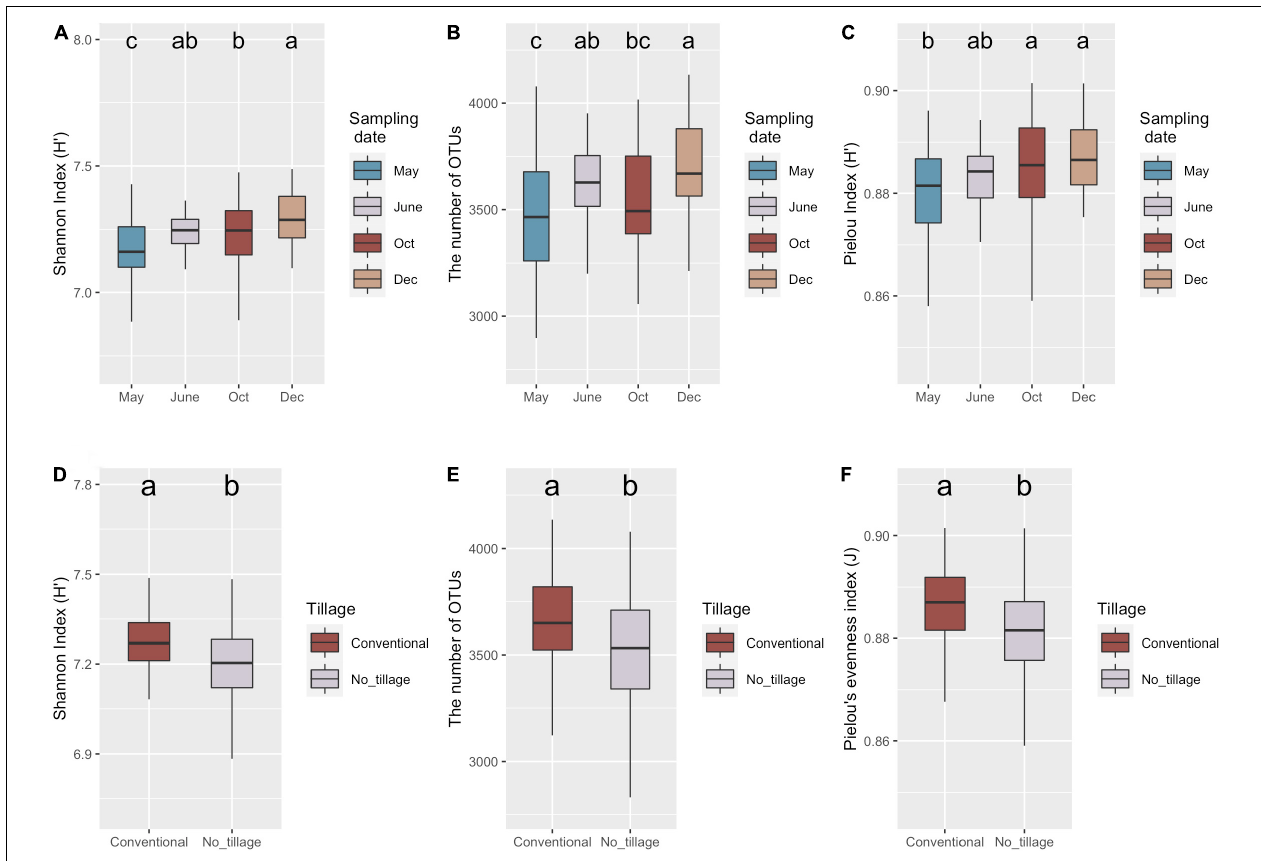
FIGURE 2 | Variations of soil bacteria diversity under long-term management practices during the cotton production cycle. Boxplot of bacterial richness and evenness across four sampling dates (A–C) and tillage management. Shannon (A,D) , the number of OTUs (B,E) , and Pielou’s evenness (C,F) indices represented bacteria alpha-diversity, richness, and evenness, respectively. Minimum value, first quartile (Q1), median, third quartile (Q3), and maximum value were shown in the plot. The significance ( p < 0.05) was represented by lower letters above the boxes; the boxes that shared same letter have no significant differences from each